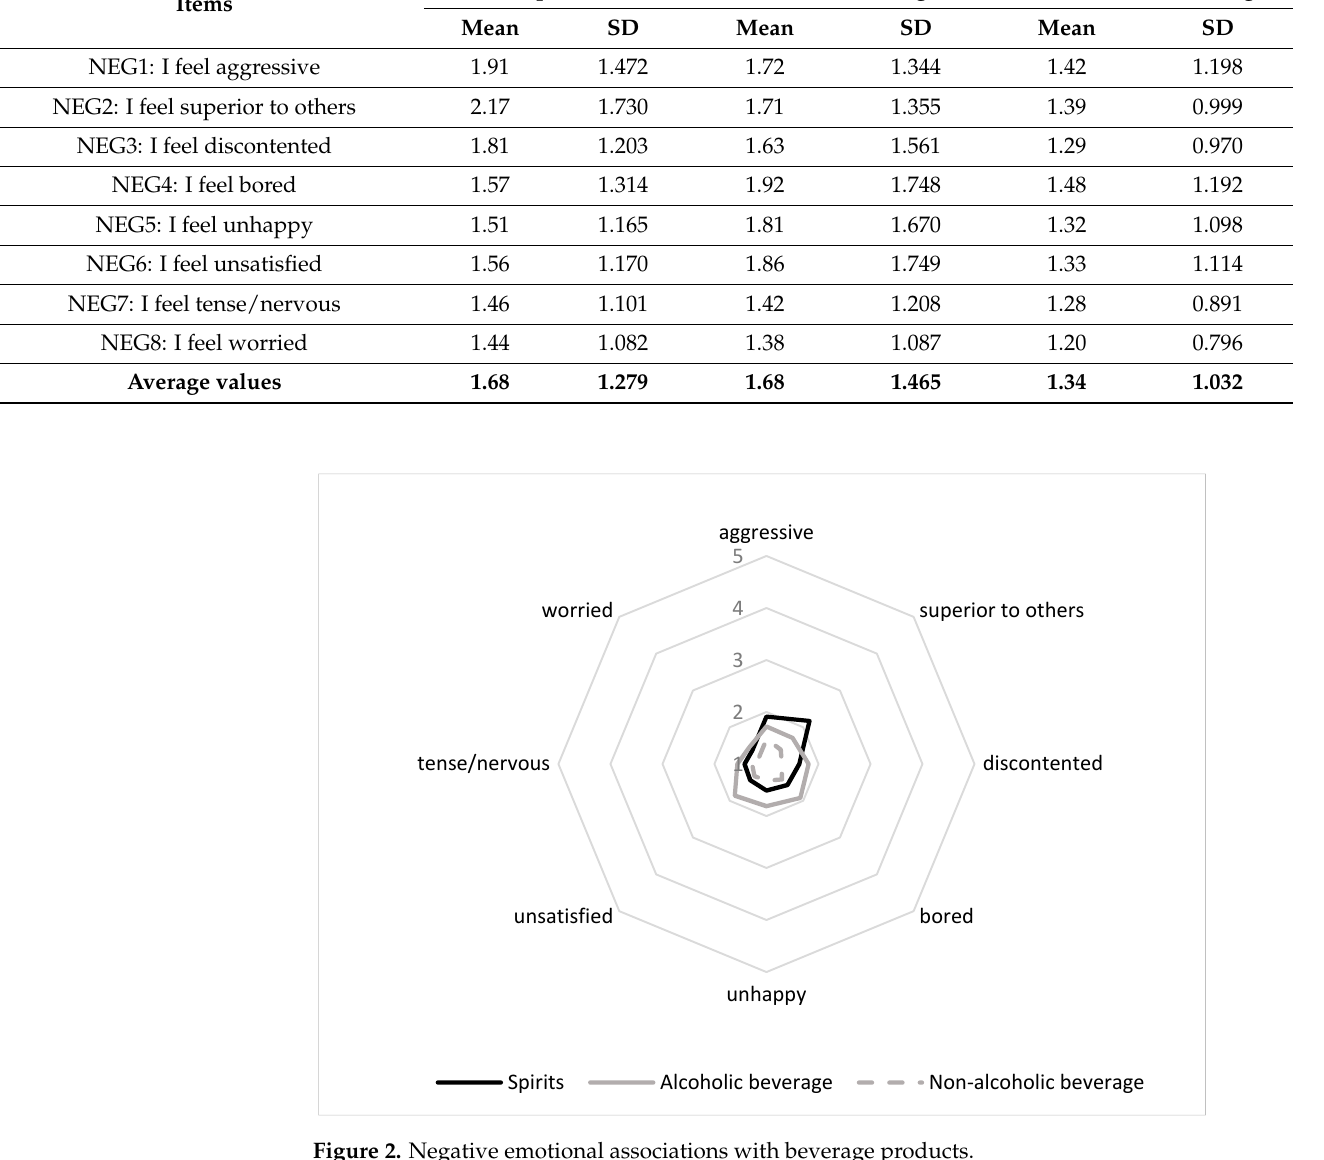
Table 3. Descriptive measures for negative emotions.